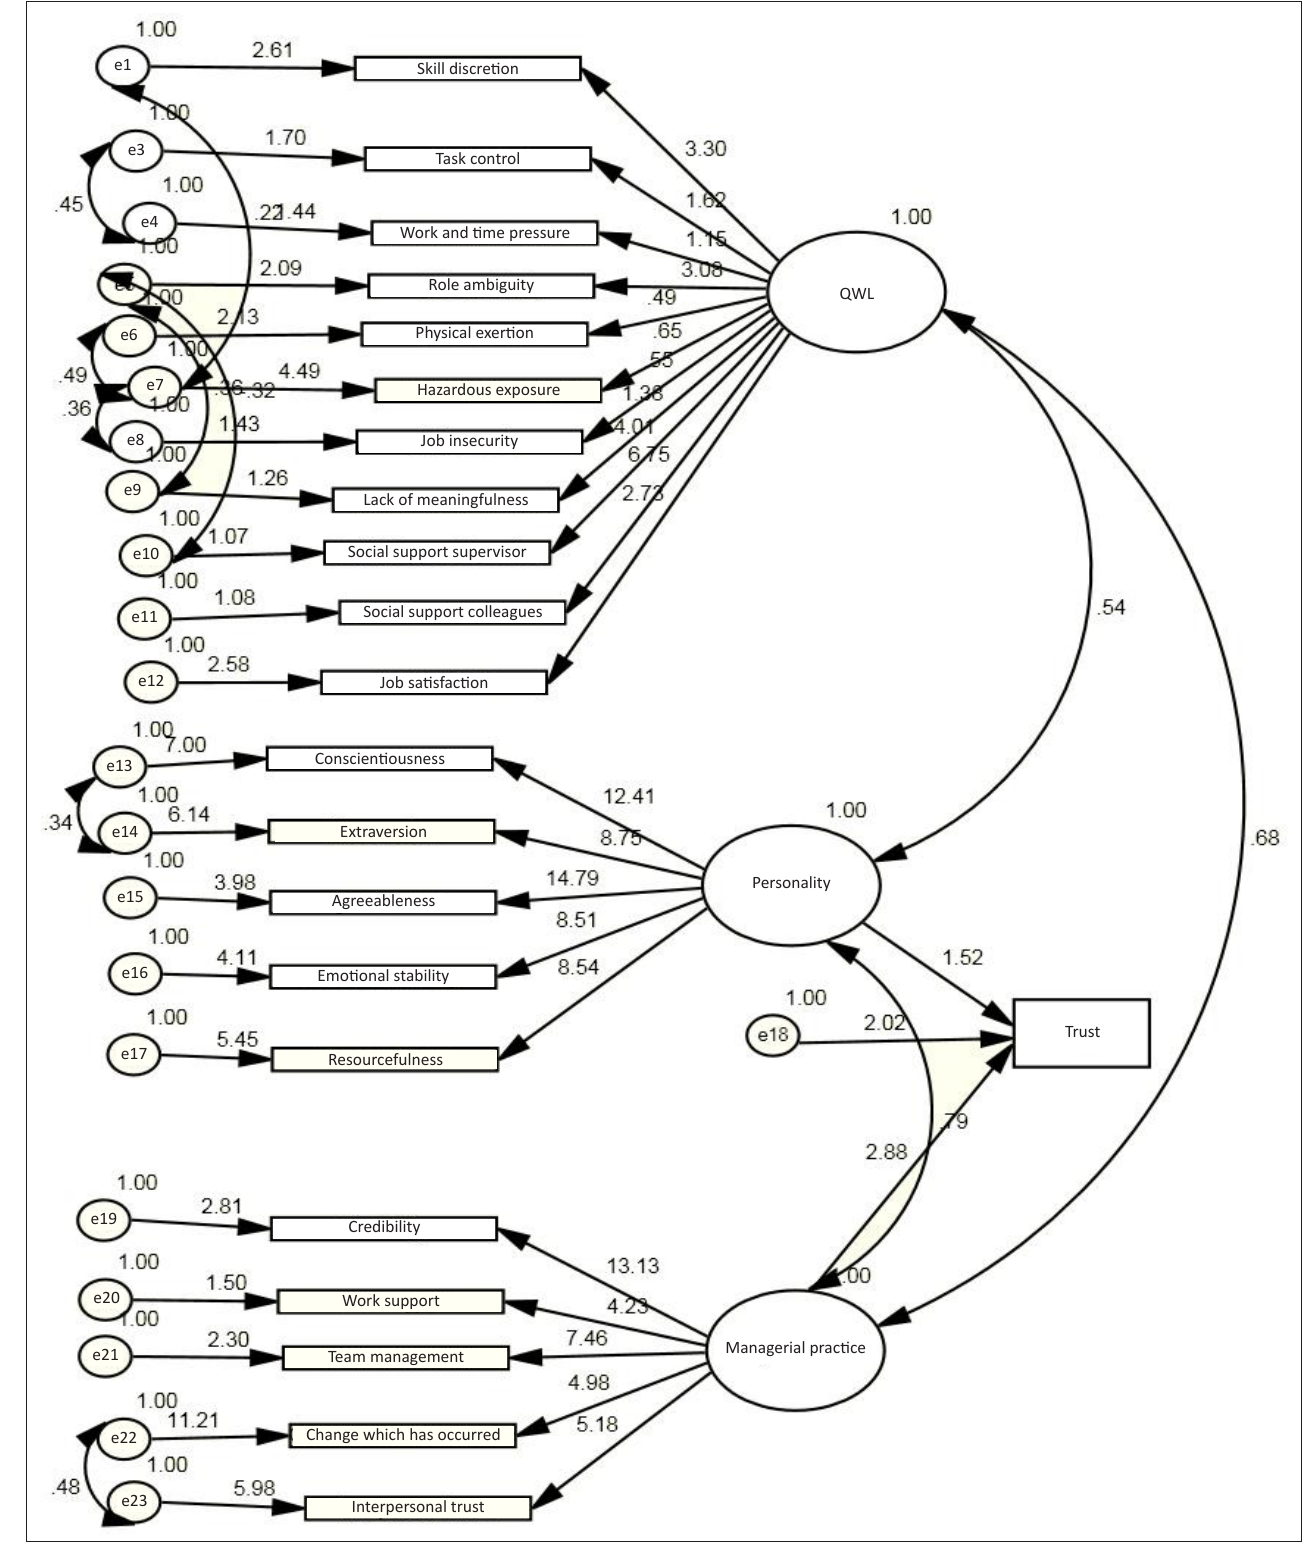
e, error terms; QWL, quality of work life. FIGURE 1: Model 2 – Relationship between organisational trust and quality of work Model 2: Relationship between organisational trust and quality of work life In Model 2, the relationship between the constructs of organisational trust and QWL is depicted. The path diagram and parameter estimates are illustrated in Figure 1. Results